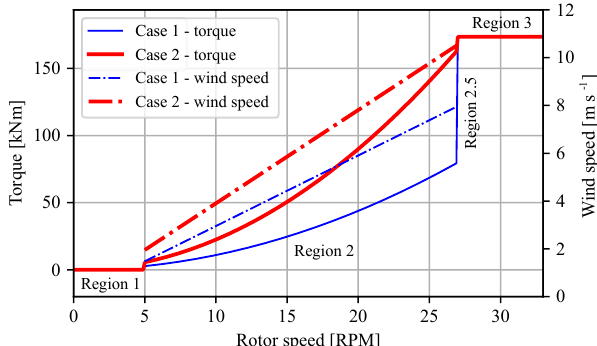
Figure 12. Torque control strategies for maintaining a fixed tip- speed ratio λ , tracking the optimal power coefficient C p , max (case 1) and the maximum torque coefficient C τ, max (case 2). The dash- dotted lines show the wind speed corresponding to the distinct strategies (right y axis), and the vertical dashed lines indicate boundaries between operating